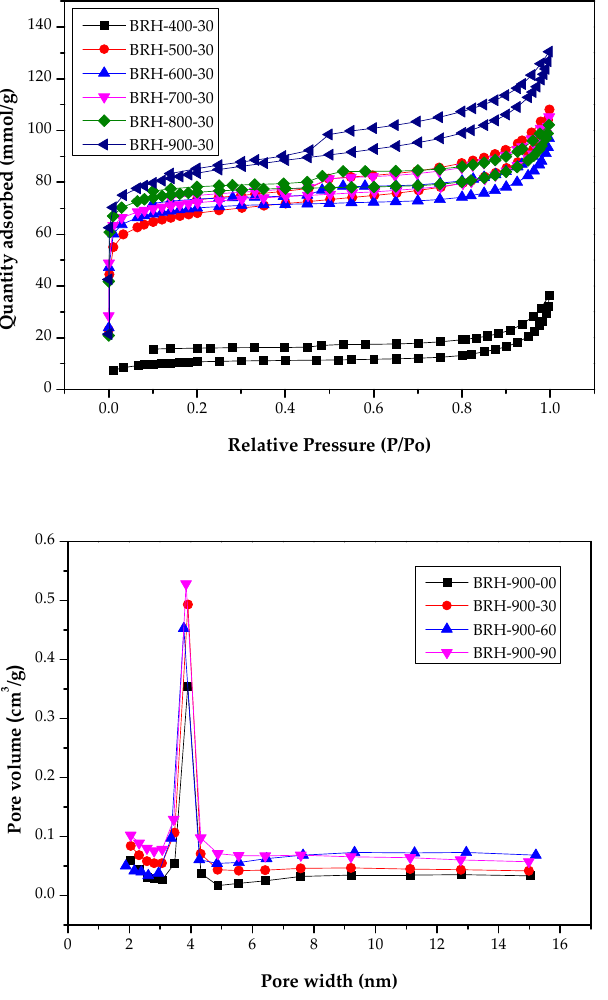
Figure 3. N 2 adsorption–desorption isotherms ( upper ) and pore size distributions ( lower ) of resulting biochar prepared at various temperatures for a fixed holding time of 30 min.